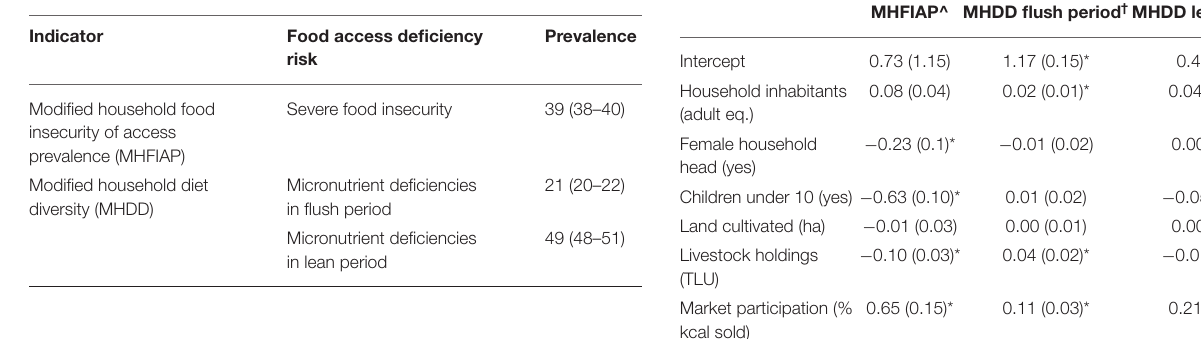
TABLE 1 | Prevalence of severe food insecurity (MHFIAP) and below household diet diversity (MHDD) threshold, weighted by population ( n = 6,353; % of weighted sample; 95% CI in parentheses).